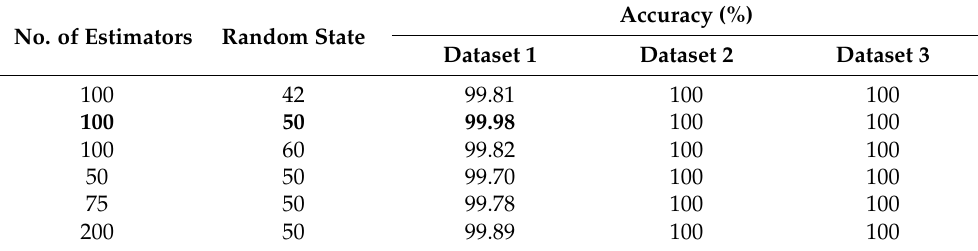
Table 6. Recognition Accuracy at Different Estimators and Random State Value.